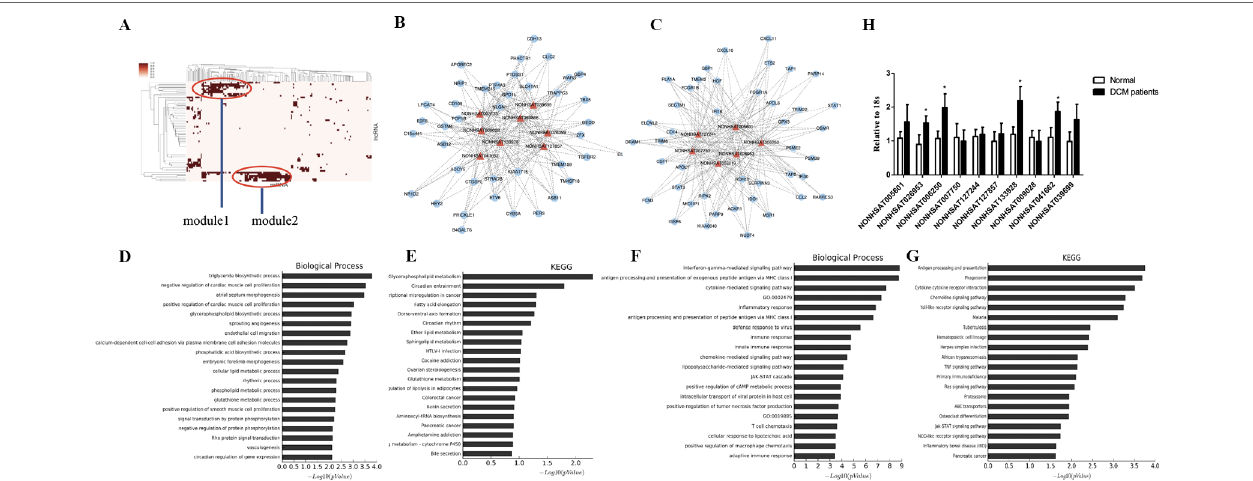
FIgURE 5 | Module analysis of the DCM-related lncRNA-miRNA network. (A) . 2 modules were identified highly related to DCM. (B, C) . lncRNA-mRNA networks in 2 modules. The triangle represents lncRNA and the circle represents mRNA. (D–g) . Biological function and pathway analysis of differentially expressed mRNA